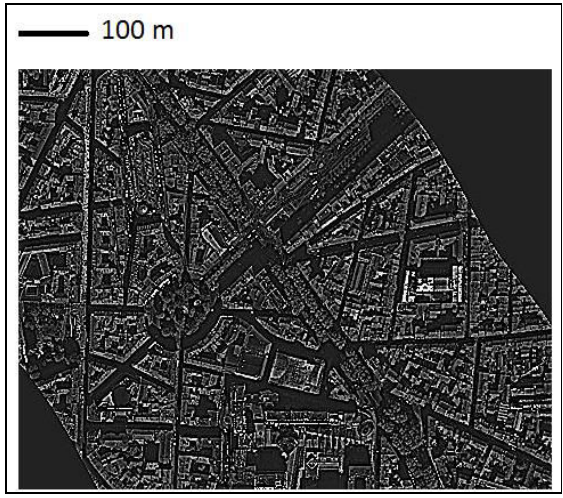
Figure 2. HySpex filtered hyperspectral data (Enhancement by PCA and Laplacian convolution filter) After the image enhancement step, the pixels of the image are grouped into segments using a structural segmentation algorithm, with a possibility to control the scale and merge level (Figure 3). The segmentation step permits to classify pixels into polygons, each polygon is characterized by its own attributes.